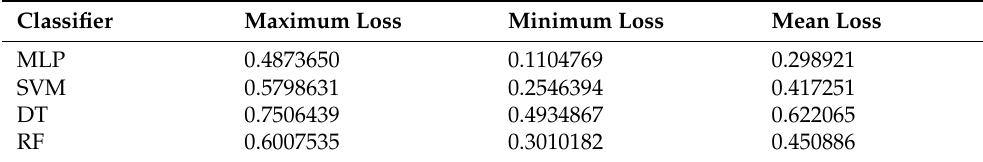
Table 6. Estimated loss functions for used